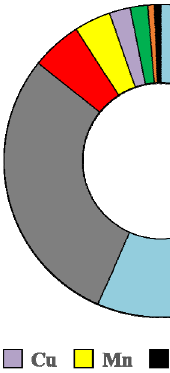
Figure 2. Average % distribution of suspended particles fraction.